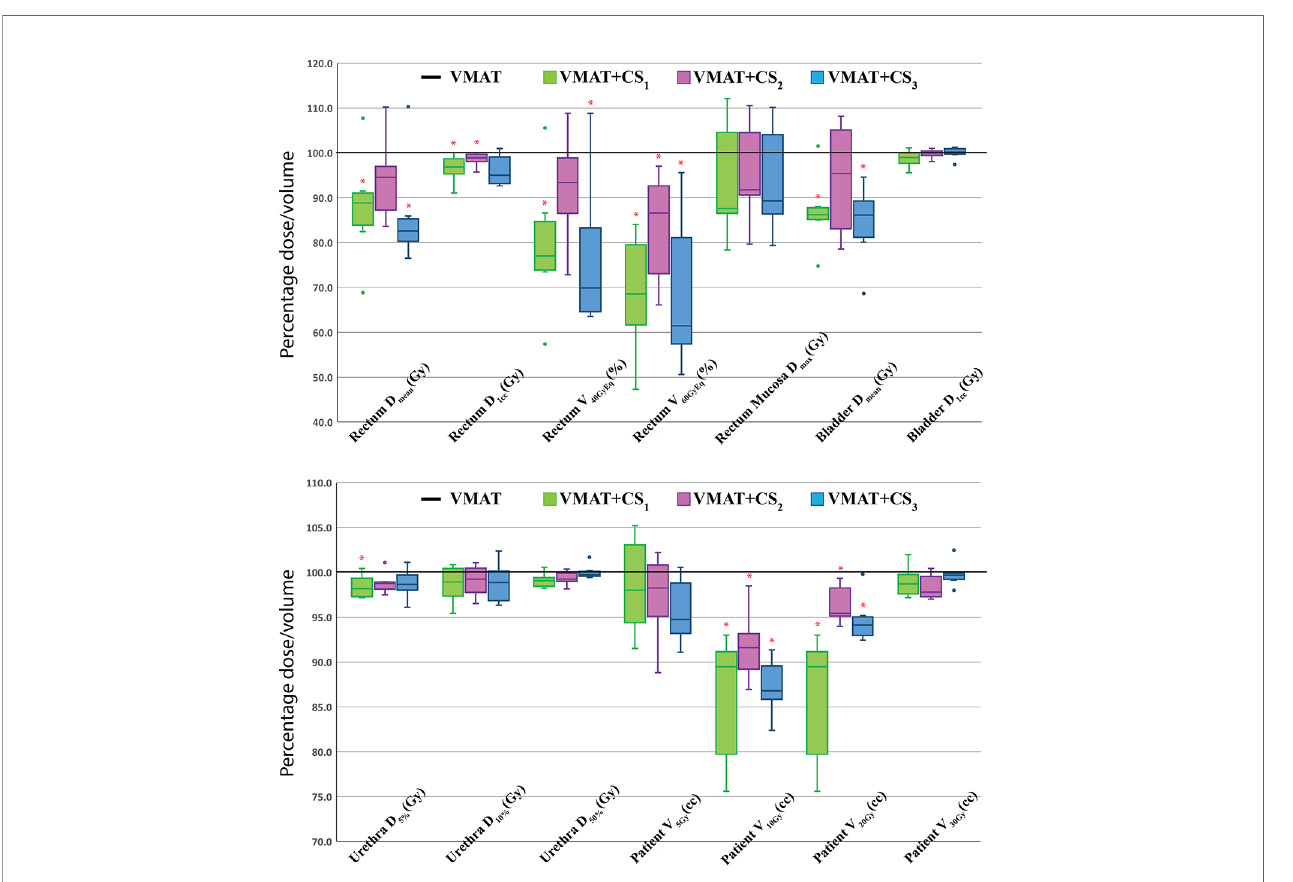
FIGURE 4 | Healthy tissue dose parameters for VMAT+CS 1 , VMAT+CS 2 , and VMAT+CS 3 plans relative to VMAT (VMAT always 100%) for the 6 randomly selected patients used to compare the class solutions. All plans were normalized to deliver the clinically required PTV coverage (V 38Gy =95%). The central line of each box represents the median value, and its upper and lower edge the 25th and 75th percentiles, respectively. The whiskers extend to the minimum and maximum values, or to 1.5 times the inter-quartile range from the top/bottom of the box. Values outside this range are plotted individually as outliers ( ‘ ° ’ ). *: difference with VMAT is statistically signi fi